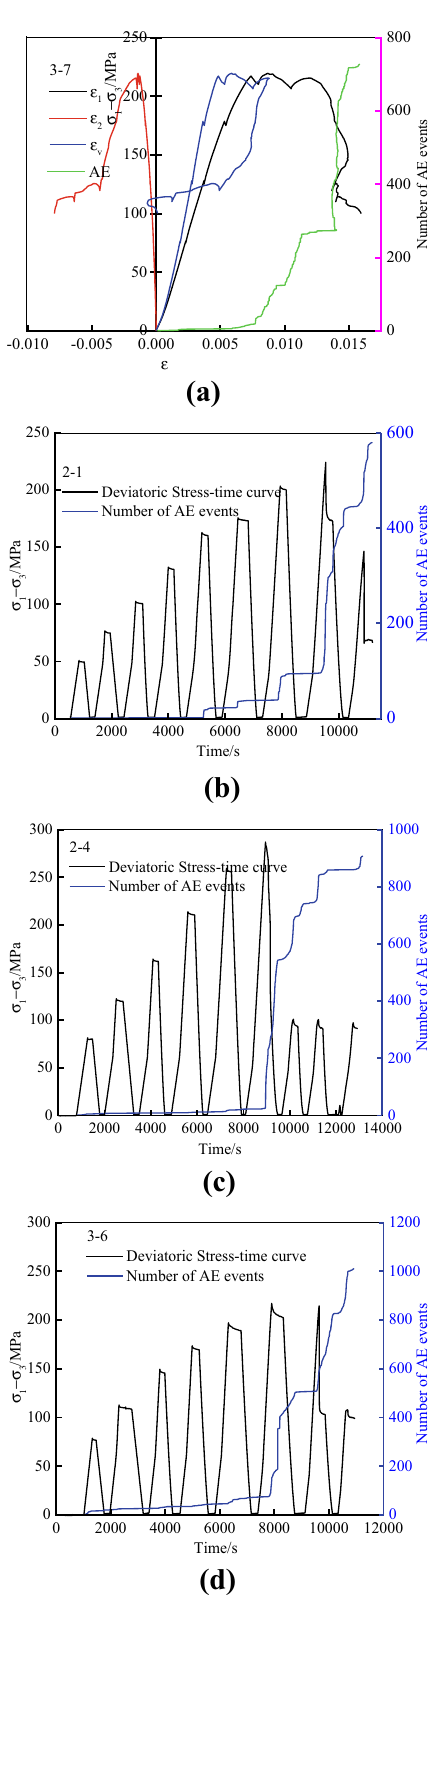
b Fig. 3 AE accumulative curve relationship with stress: a specimen 3–7, b specimen 2–1, c specimen 2–4, d specimen 3–6